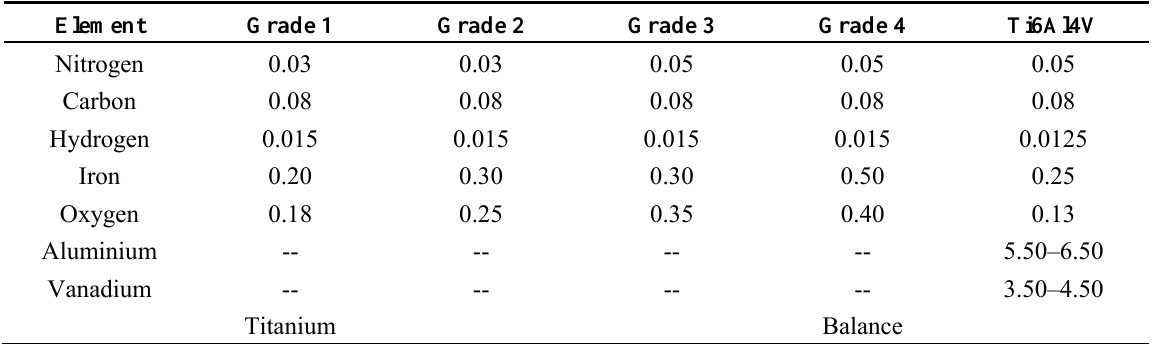
Table 1. Chemical composition of titanium and its alloys (% mass/mass)